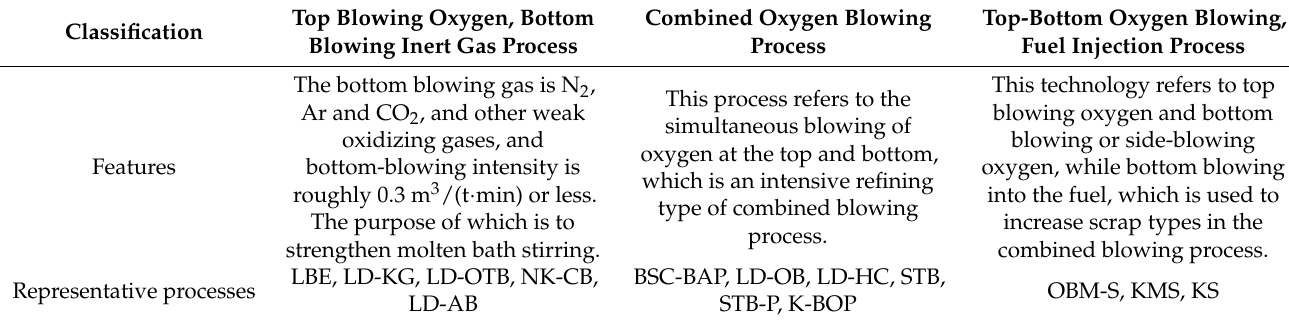
Table 4. Three different types of combined blowing